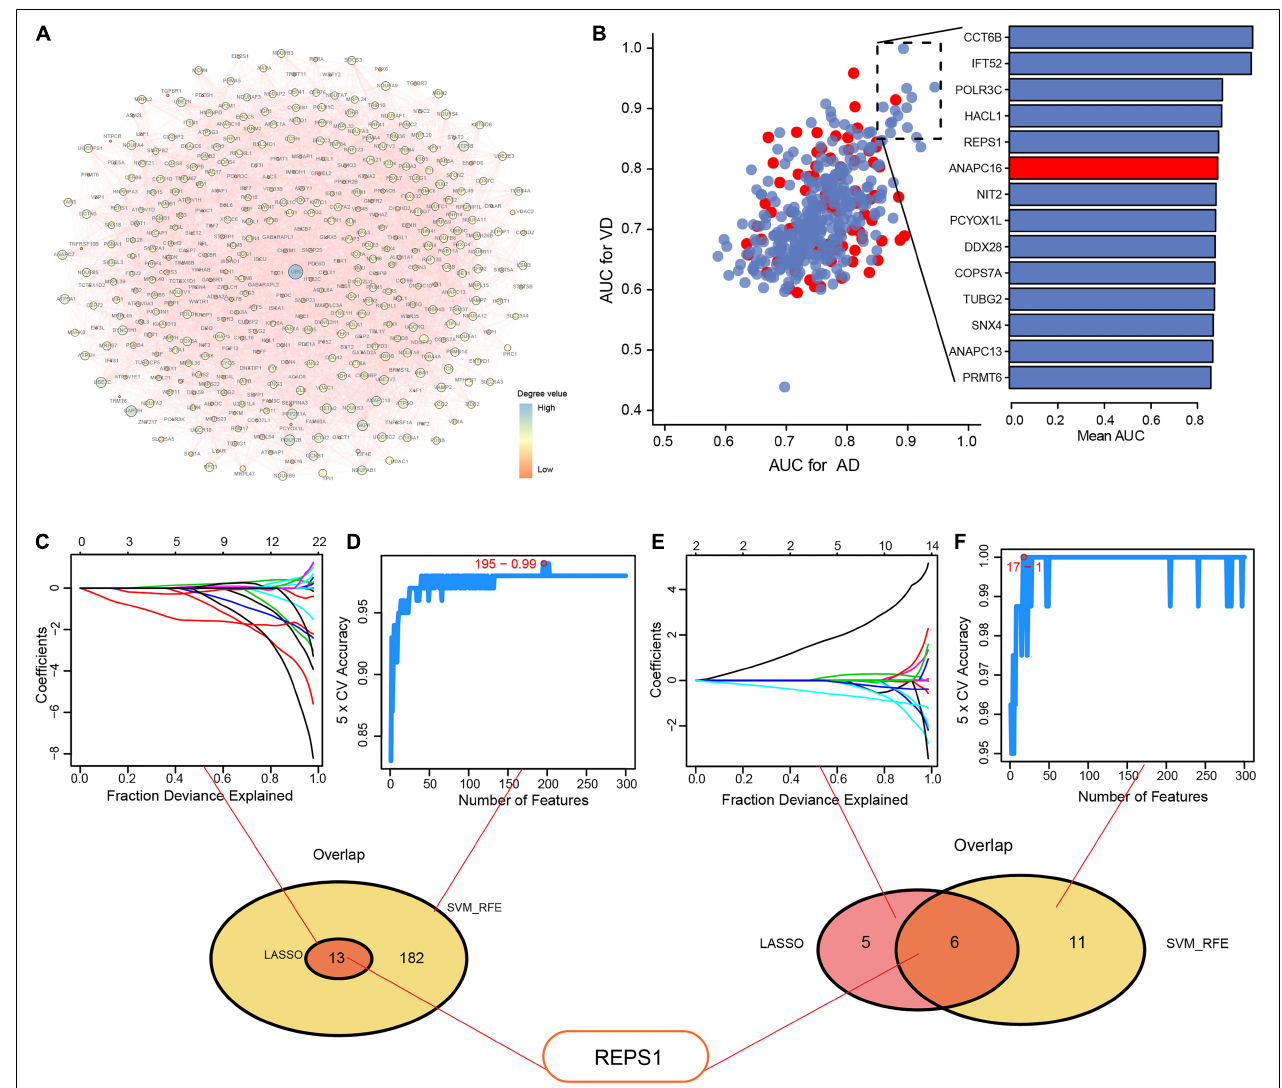
FIGURE 4 | Identification of hub genes using LASSO and SVM-RFE. (A) Protein–protein interaction network to reveal module genes. (B) Evaluation of the diagnostic value of module genes involved in Alzheimer’s disease (AD) and vascular dementia (VD), based on the area under the receiver operating characteristic curve (AUC). Red indicates upregulated genes; blue, downregulated genes. (C–F) Module genes were entered into LASSO and SVM-RFE to obtain the overlapping feature genes in (C, D) AD or (E, F) VD. Feature genes are identified using different colors in (C) and (E) . LASSO, least absolute shrinkage and selection operator; SVM-RFE, support vector machine-recursive feature